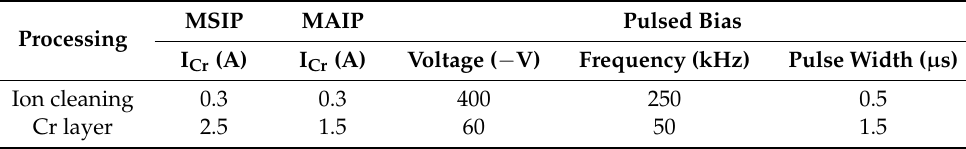
Figure 1. Deposition process of the chromium coatings and schematic diagram of vacuum chamber (top view). Table 1. Process parameters of the magnetron sputtering ion plating and the micro-arc ion chromium plating on GCr15.